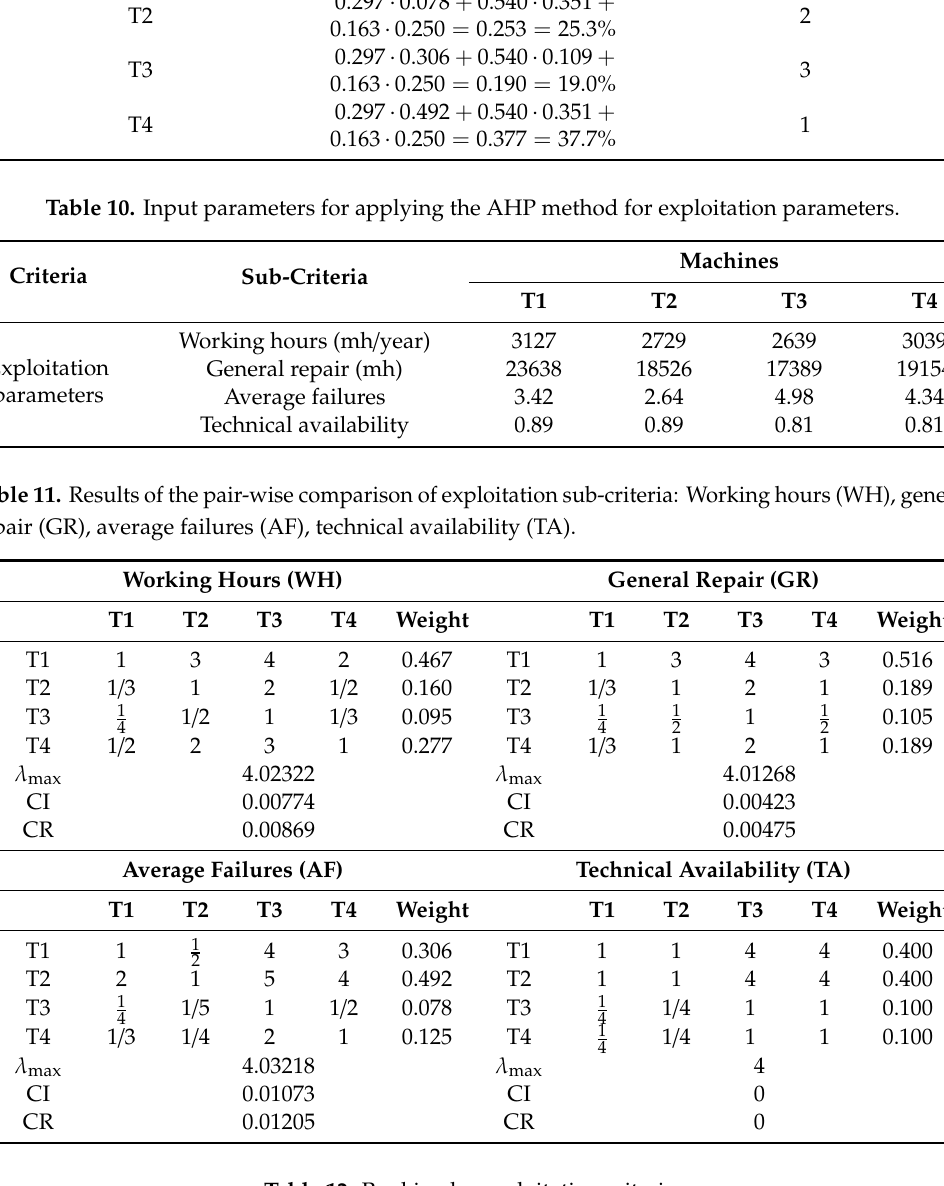
Table 12. Ranking by exploitation